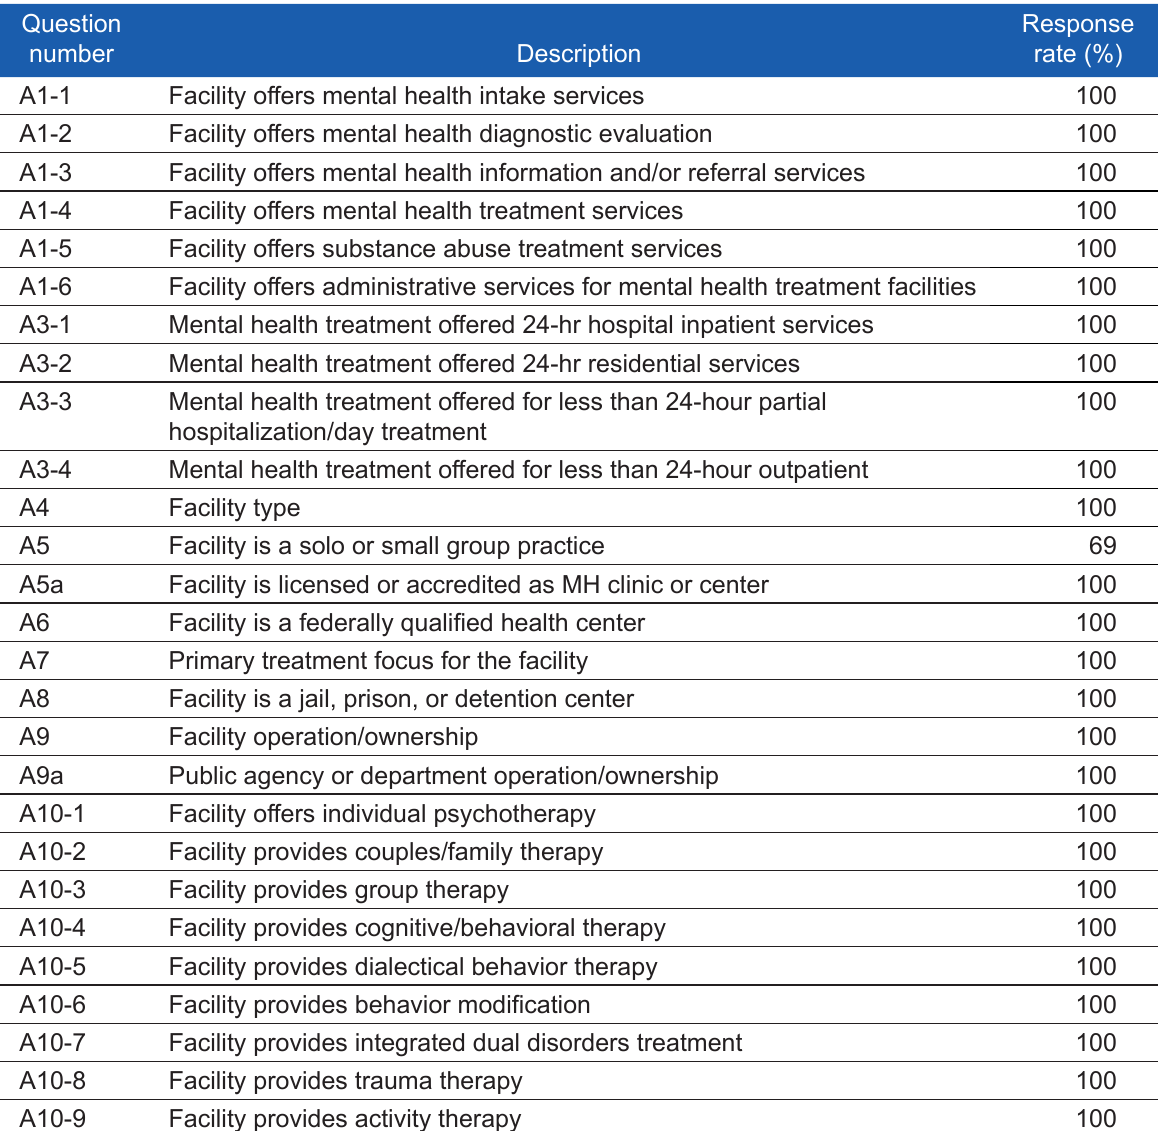
Table C1. Item response